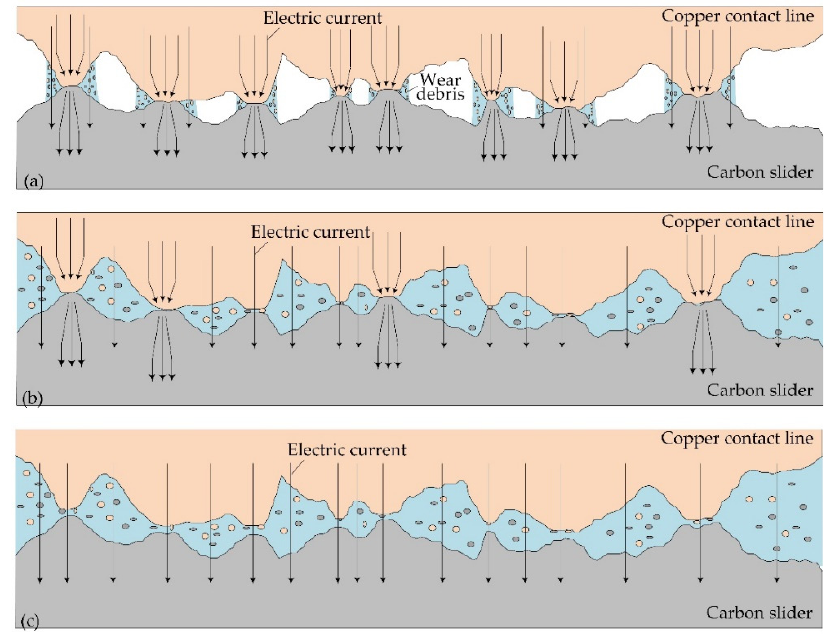
Figure 10. Water film distribution and current transmission path at contact interface with different water contents ( a − c ).